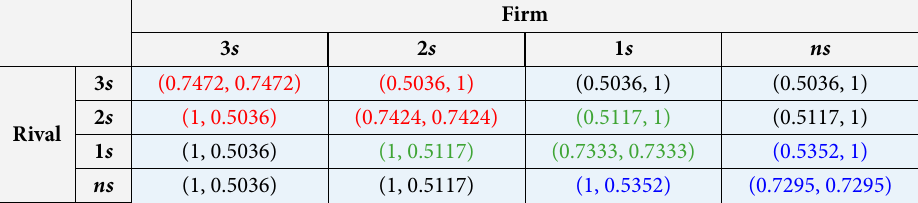
Table 2. Technological transition: two observations, risk-neutral DM, and signals on X 1